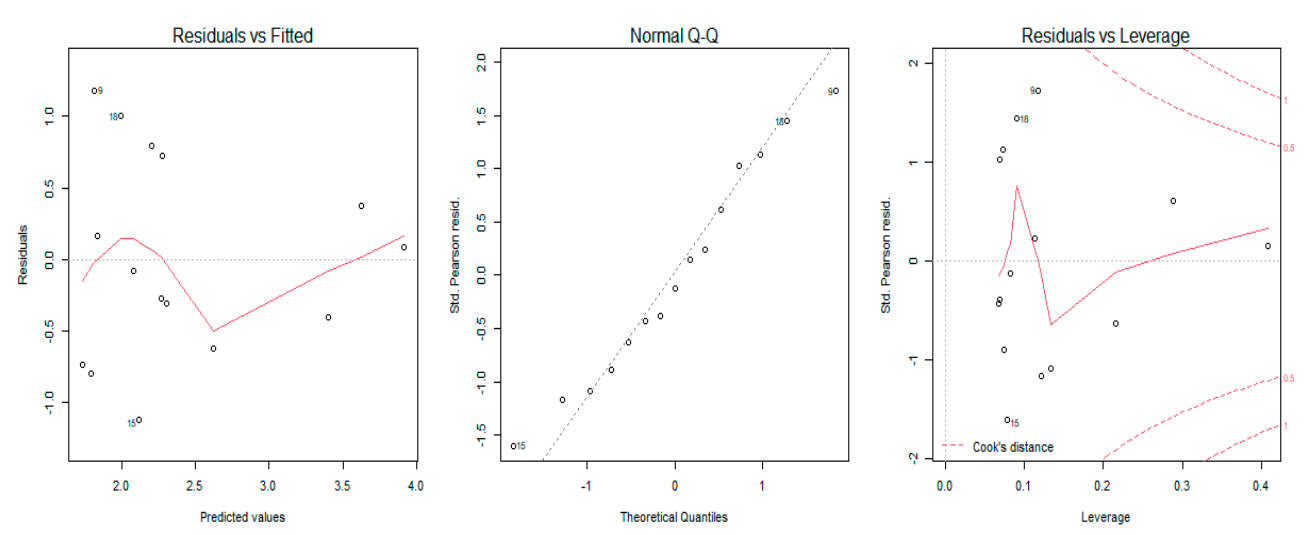
Figure 2. Graphical residual analysis for the MRC model and sEMG for the biceps brachii muscle. The plot on the left shows the residual errors versus their estimated values and the points on the graph should be arranged randomly. The QQ plot in the center shows the distributive normality of the residuals and the points on the plot should follow the diagonal line. The plot on the right identifies any influential data points on the model. In the plot, the Leverage’s values of the points and the Cook’s distances that measure the influence of each observation on the estimation of the model parameters are present. Cook’s distance values greater than 1 are suspect and indicate the presence of a possible outlier or poor model.